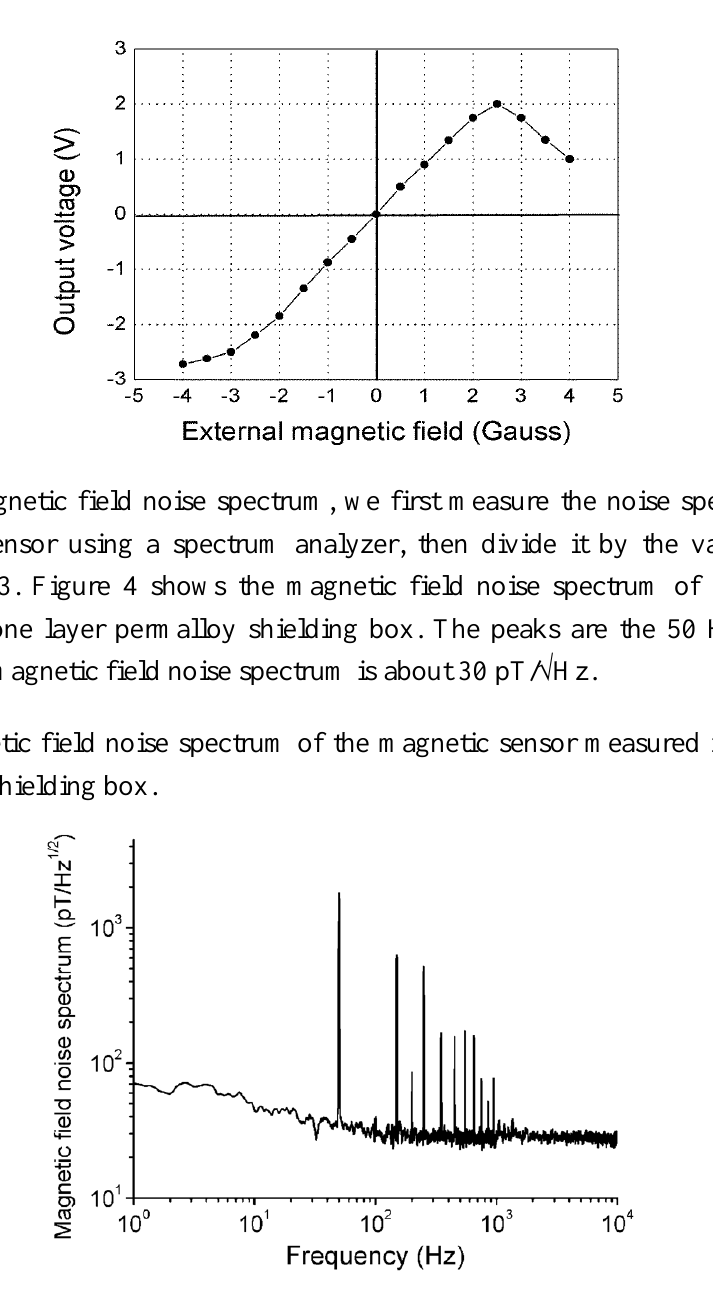
Figure 3. Output voltage changes with the external magnetic field when the static bias magnetic field is about 2.5 Gauss.